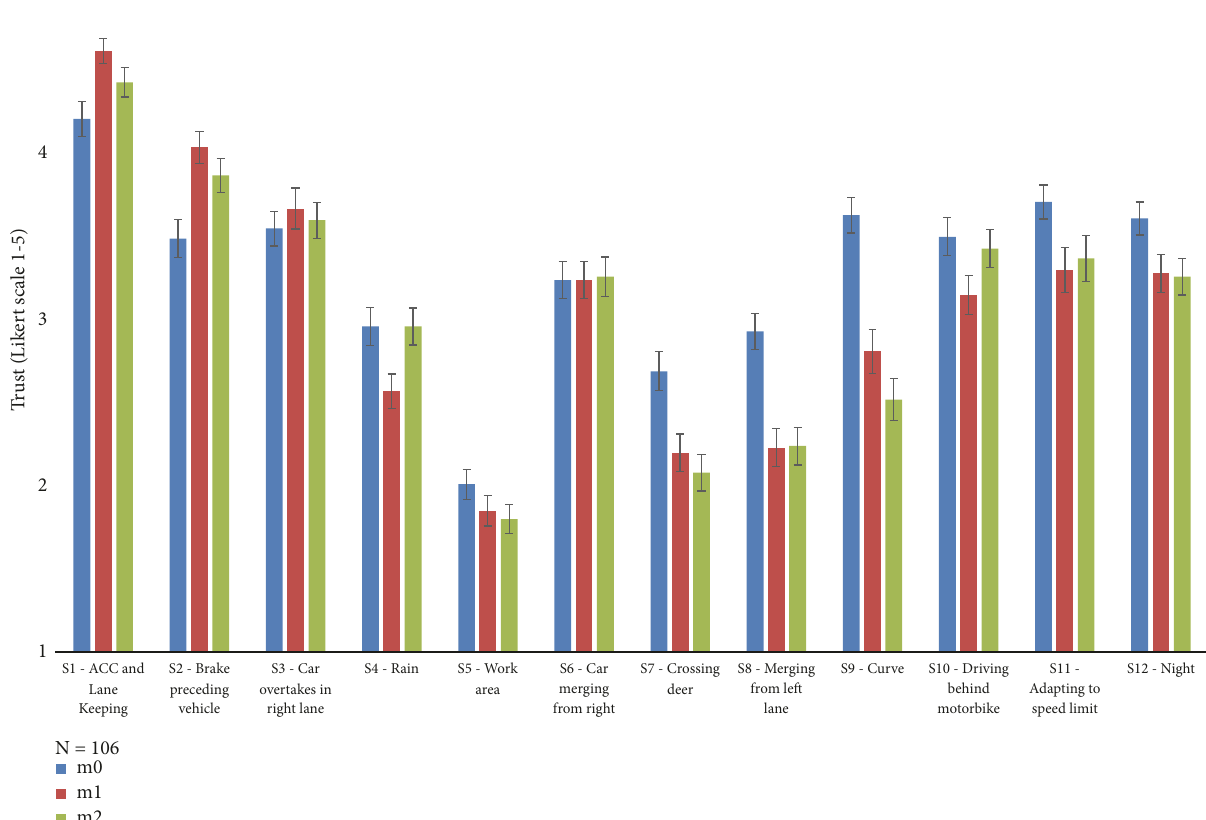
Figure 3: Questionnaire results. Scenarios (S) one to twelve are displayed from left to right, respectively. For scenarios 1 and 2, drivers’ trust significantly increased after experiencing the vehicles. Conversely, for scenarios 4, 7, 8, 9, and 12, drivers’ trust significantly decreased after experiencing the vehicles. No significant trust changes between pre- and postmeasurements were found for scenarios 3, 5, 6, and 11. For scenario 10, significant differences were found between the pre- and the “2-week” measurement (i.e., m2), but not between m0 and m1. 𝛼 = .004. Error bars were calculated based on the standard error of the